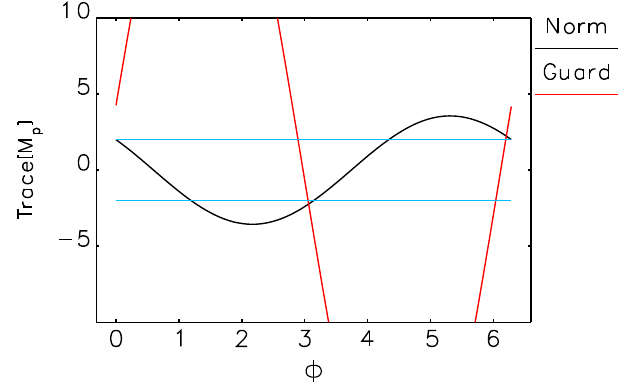
25. Trace of the periodic matrix for a normal train with gaps, compared to a train with guard bunches. Trapping will occur when the absolute value of the trace is less then